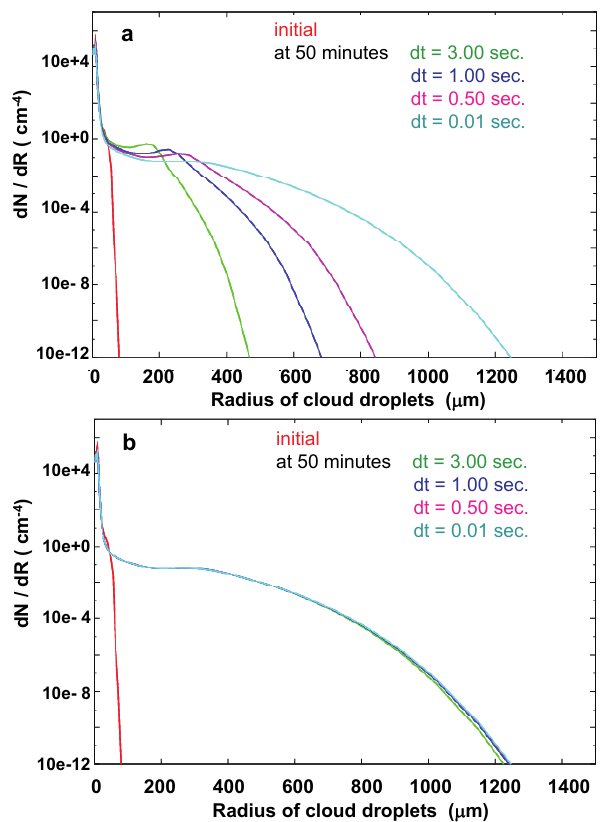
Fig. A1. Cloud droplet size distributions at the initial stage (red line) and at 50min. Cloud droplets are assumed to grow only by co- alescence. Each line shows the droplet size distribution calculated with different time steps: 3s (green line), 1s (blue line), 0.5s (pink line), and 0.01s (light blue line). (a) Coalescence is estimated using only the general stochastic coalescence scheme in which multiple coalescence in one time step is neglected. (b) Coalescence is esti- mated by the special scheme used in this study, including both gen- eral stochastic coalescence and continuous coalescence